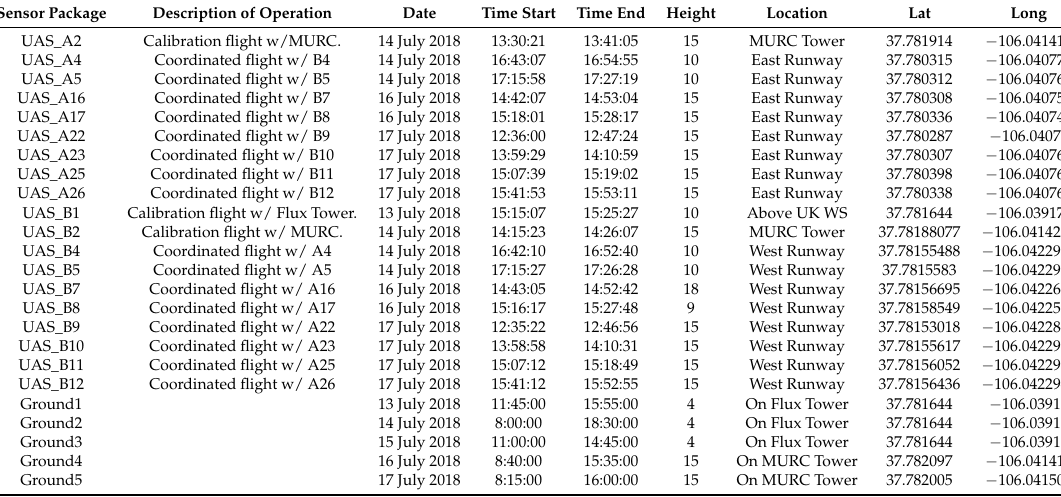
Figure 3. Calibration flight with vertical array of sensors at 10 m (UAS with Atmos 22 sonic anemometer), 4 m (Atmos22 sonic anemometer), and 2 m (CSAT3 sonic anemometer) ( left ). White arrows indicate the sensors at each of the respective heights. Calibration flight (B2) with one ground-based sensor on the MURC tower and one UAS, both at 15 m ( right ). White arrows indicate the sensors for each of the platforms. Table 1. UAS mission and ground station details. UAS sensor packages were functionally identical. Time start and time end are in local time, Mountain Daylight Time. Height is in meters above ground